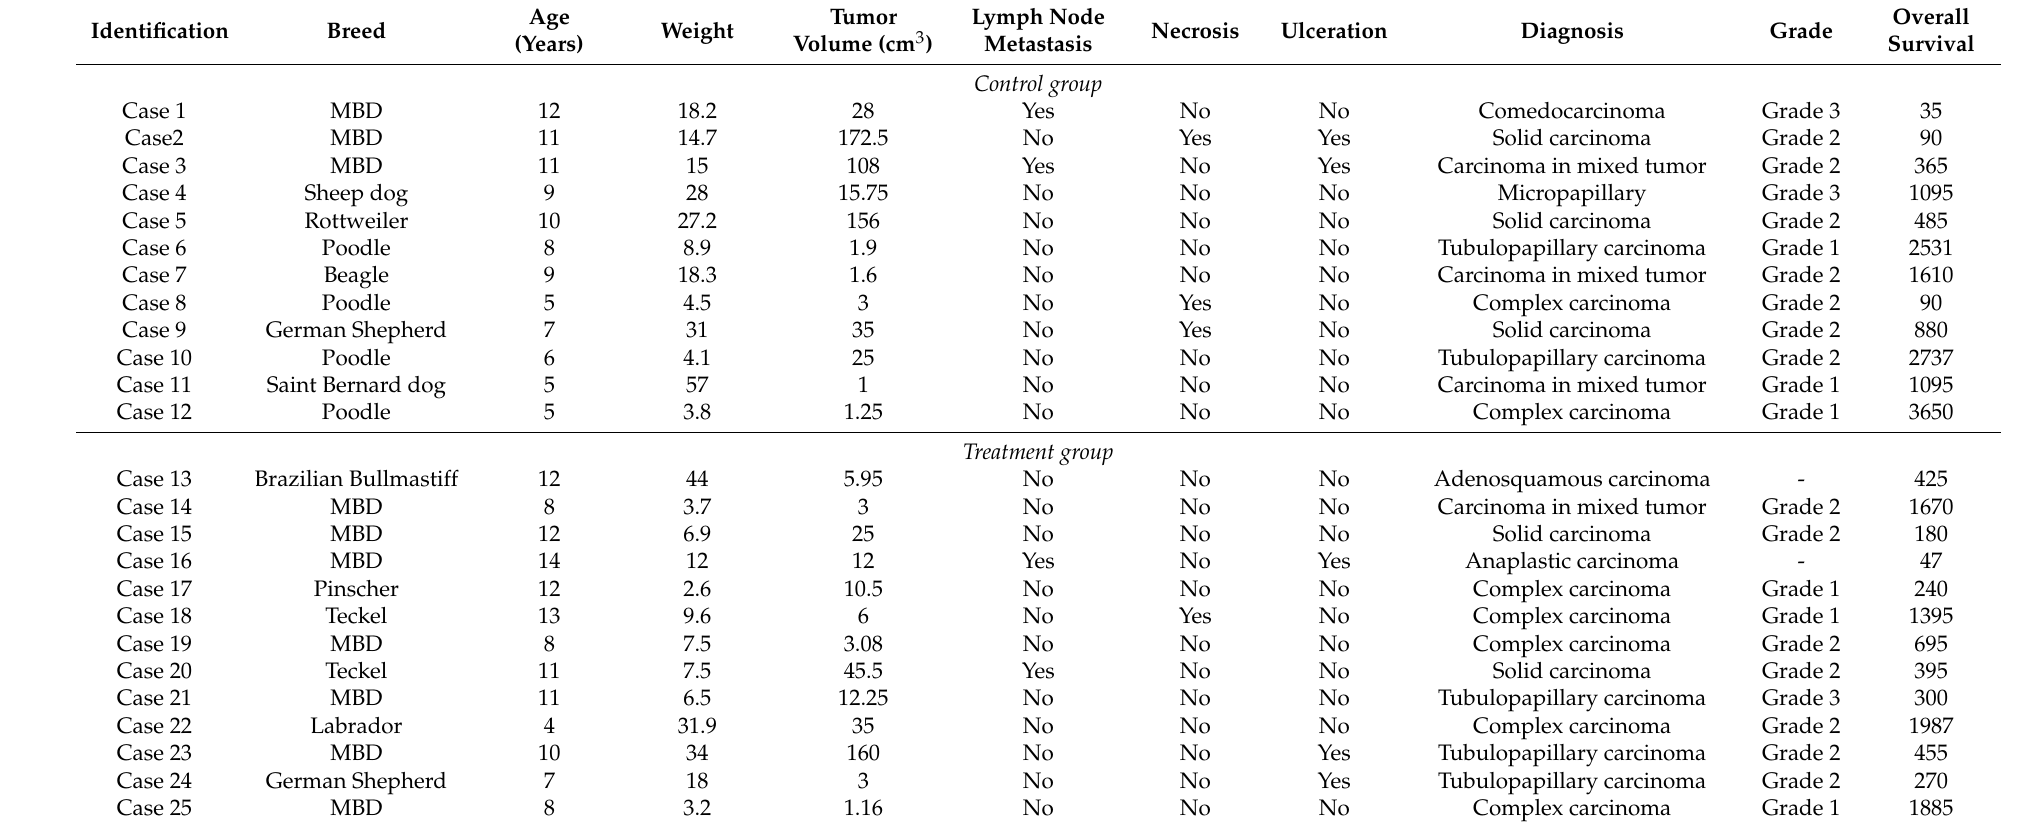
Table 2. Clinical information of the 25 canine patients used in the in vivo